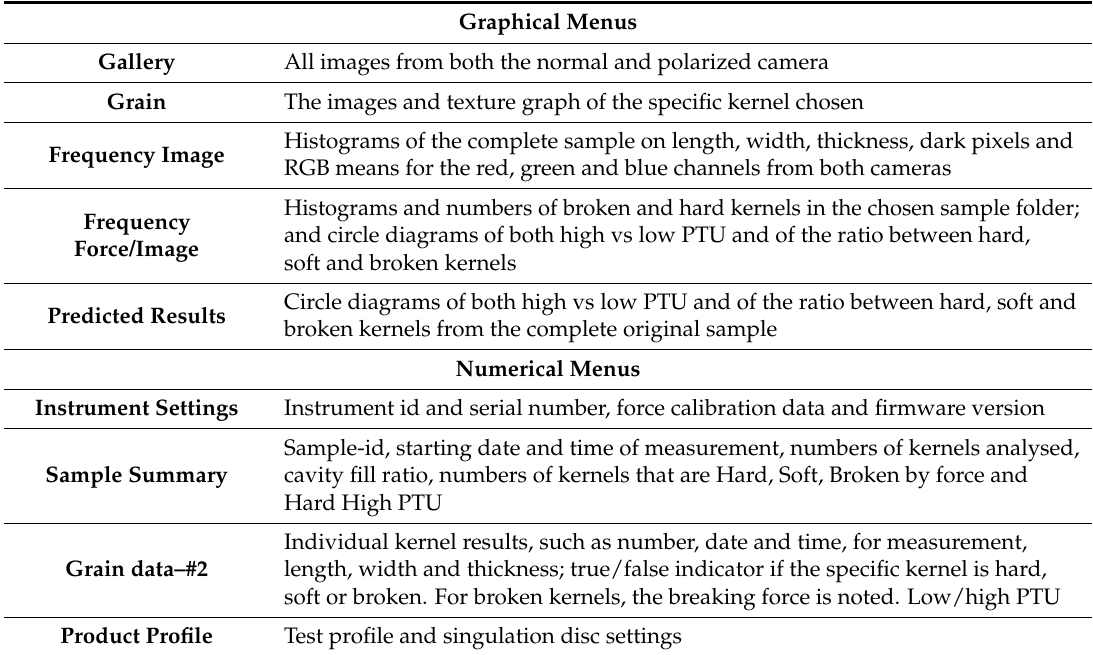
Table 2. Software information and result menus.